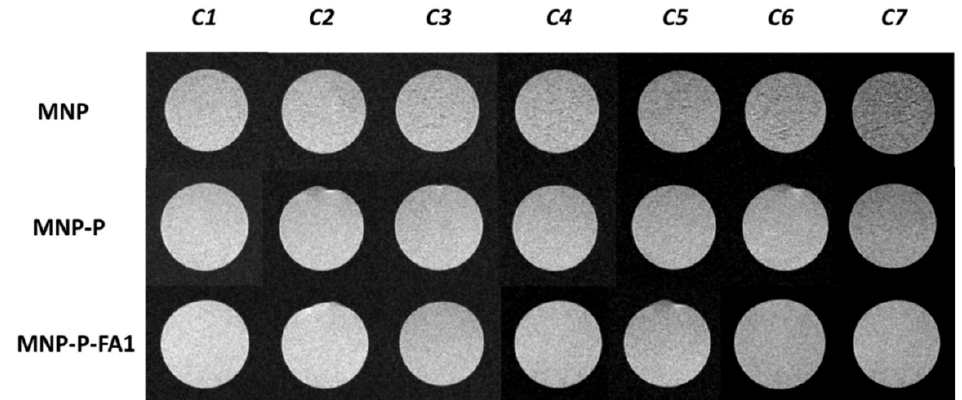
Figure 13. T2-weighted MR images of MNP, MNP-P and MNP-P-FA1 on the concentration range of Fe 3+ between 0.1 and 0.8 mM (C1–C7) showing a negative contrast by increasing the concentration.